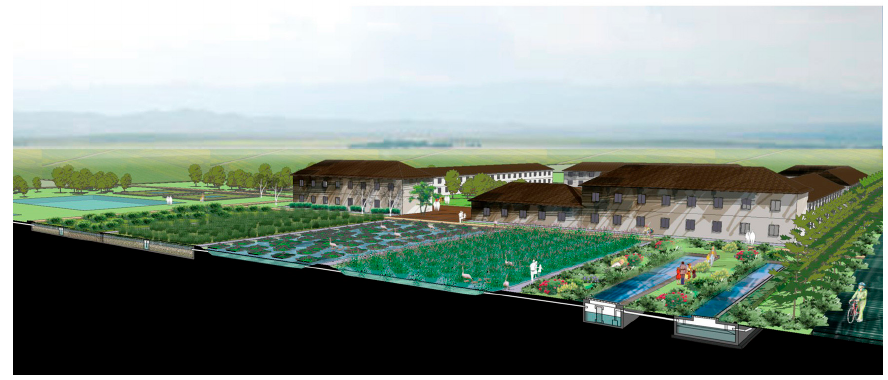
Figure 9. Prospective section of the existing farmhouse (cascina) regenerated and the new landscape designed as public space and energy production through water system.